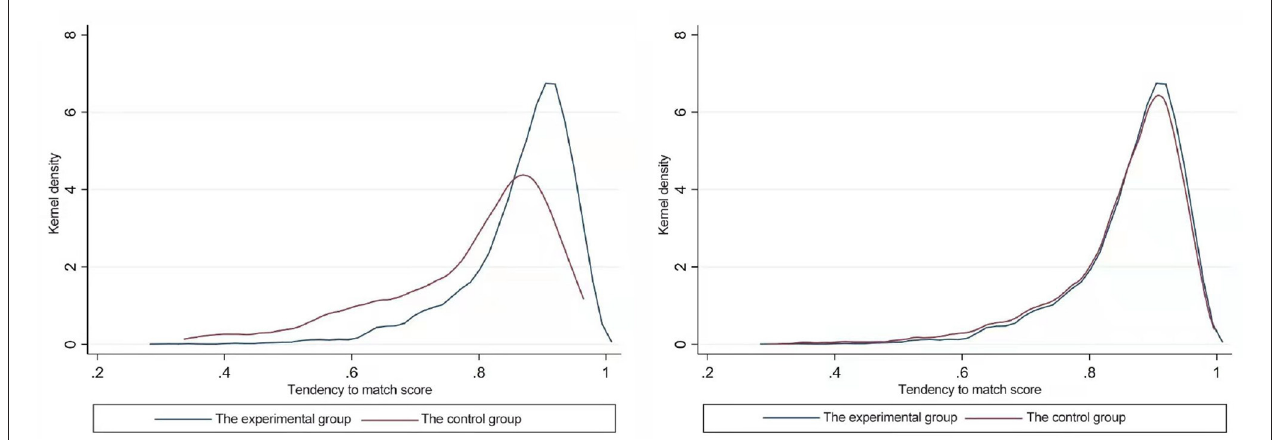
FIGURE 4 | Kernel density function before and after propensity score matching of urban-rural medical insurance